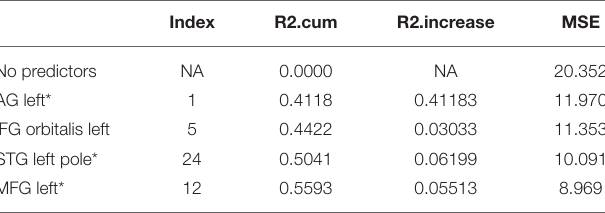
TABLE 6 | Results from a stepwise regression with the brain areas as predictors, and Trial 5 as the dependent variable.